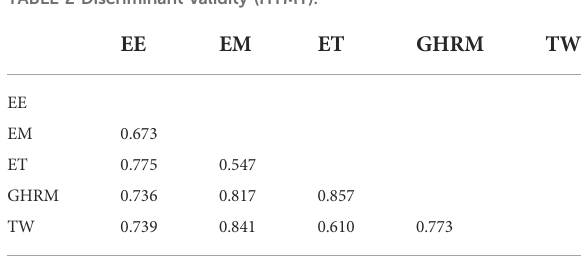
TABLE 2 Discriminant validity